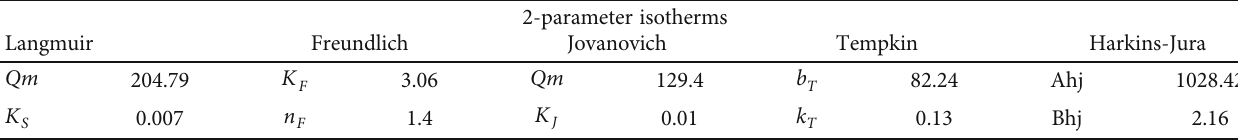
Table 4: Calculated parametric values of 2-parameter isotherms.